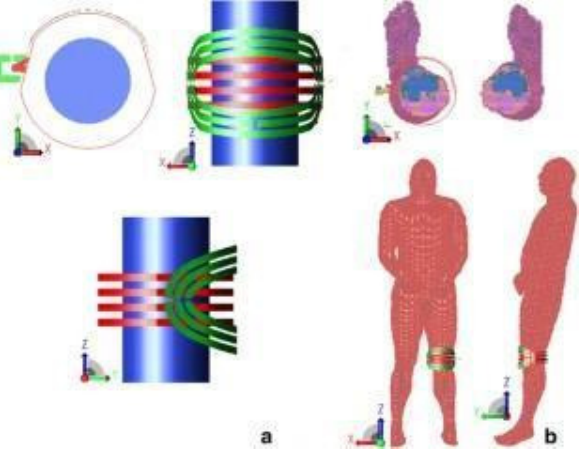
Figure 5. Knee coil in different loaded conditions: (a) homogenous cylindrical phantom and (b) human model. Reprinted from [37].